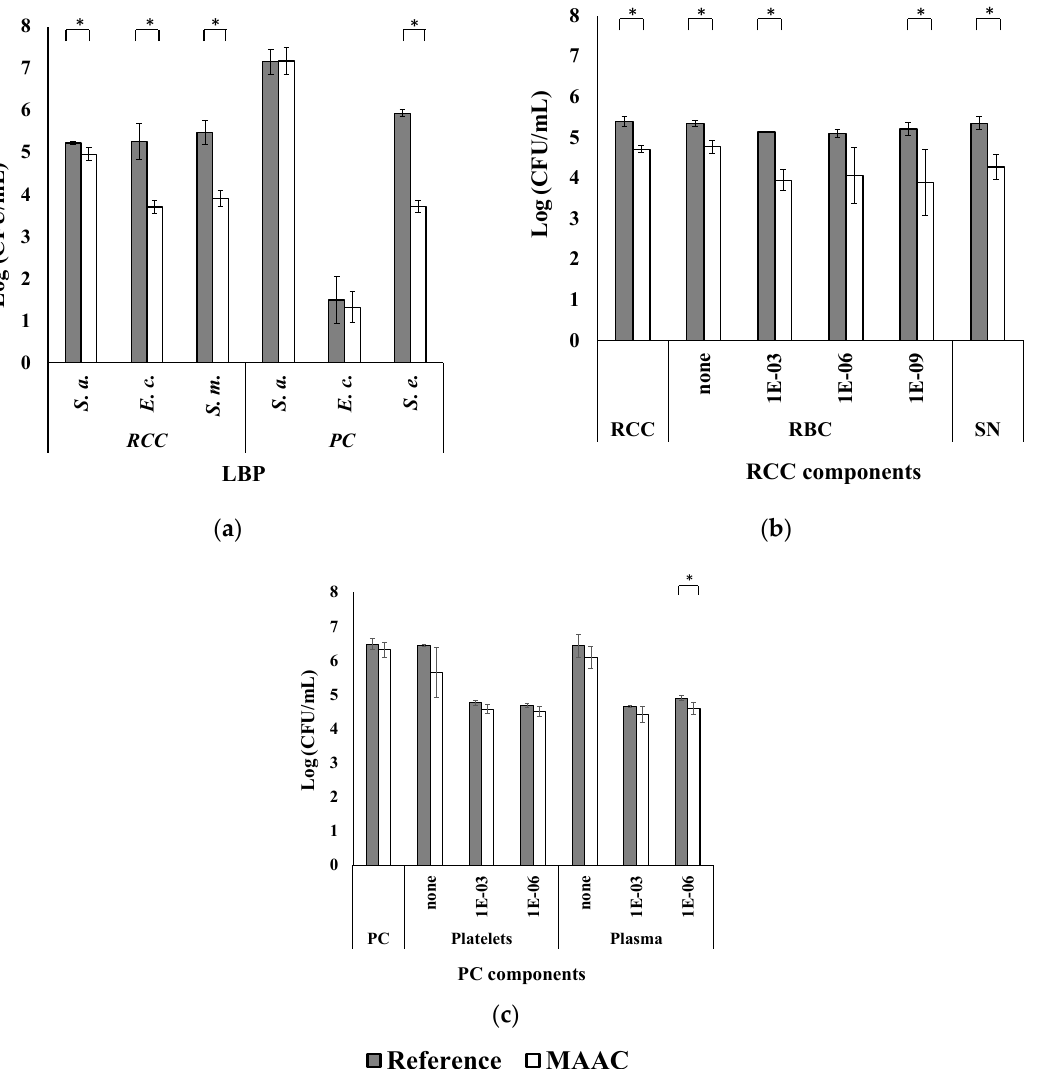
Figure 4. Logarithmic bacterial growth (mean ± standard variation) in blood products with an inocu- lum of 6 × 10 5 CFU/mL after a 24 h contact period with untreated (reference) and treated polymeric materials (MAAC). ( a ) Logarithmic growth in RCC (PVC-DEHP) or PC (PVC-BTHC) matrices using three bacteria. Logarithmic bacterial growth of S. aureus in ( b ) RCC and ( c ) PC component dilutions in saline ( n = 3). S. a. = Staphylococcus aureus ; E. c. = Escherichia coli ; S. m. = Serratia marcescens ; S. e. = Staphylococcus epidermidis ; RBC = red blood cells; and SN = supernatant. * Significant growth differences between the reference and the MAAC condition (Student t -test, α = 0.05, * p value < 0.05).